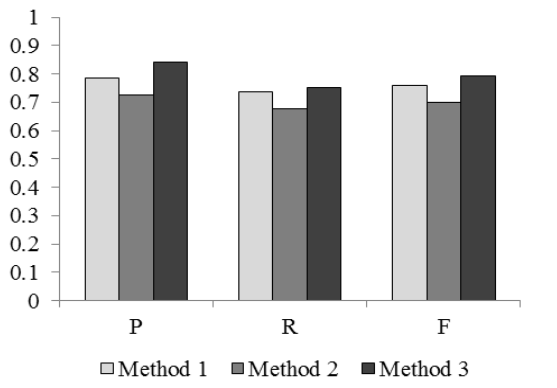
Fig. 5. Emotional tendency judgment result comparison on product